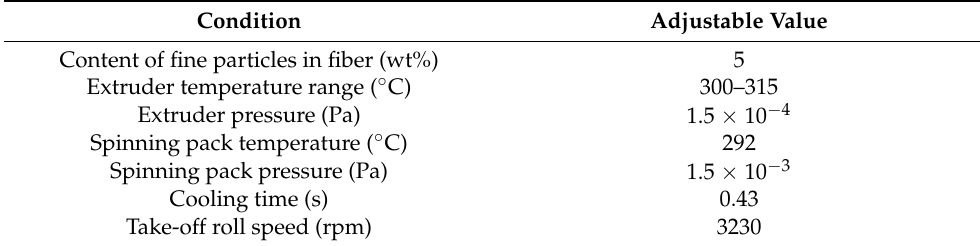
Table 1. Conditions for melt spinning yarn for shielding fiber.